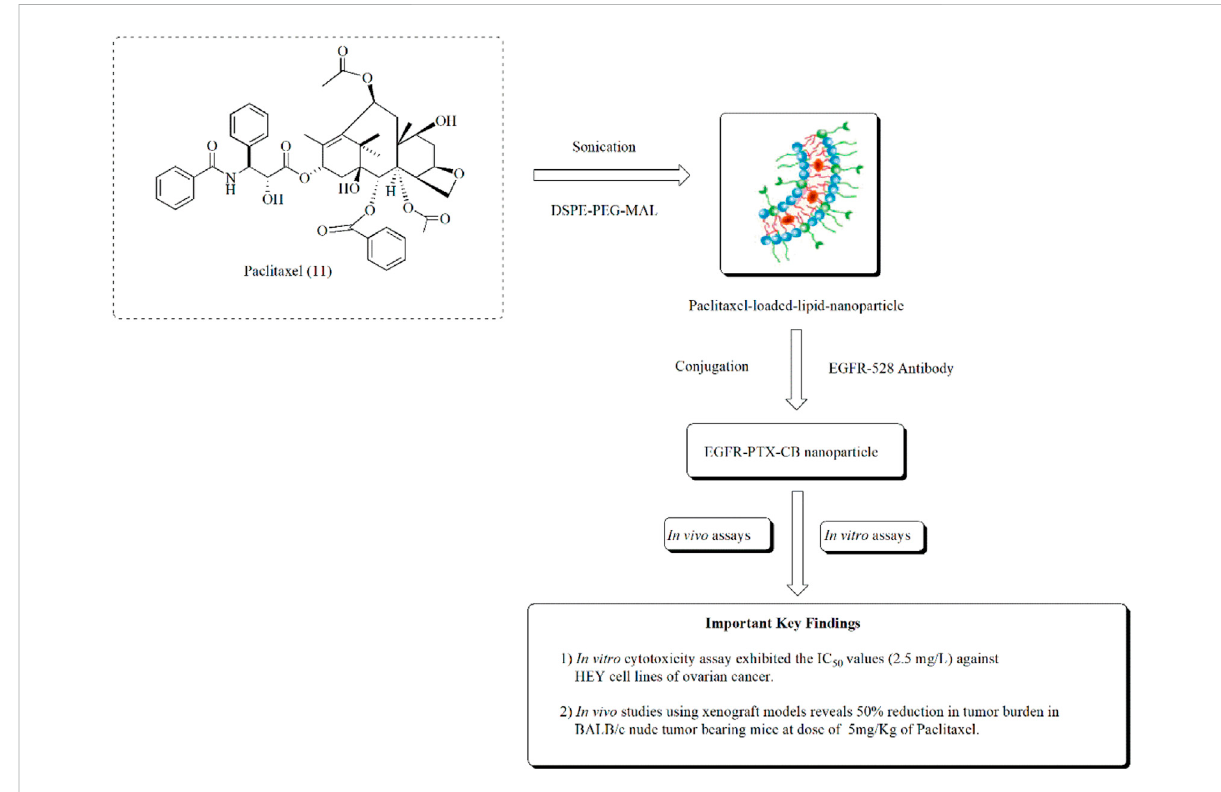
assays using BALB/c nude tumor-bearing mice were performed to assess the anti-ovarian cancer potential of EGFR-PTX-CB